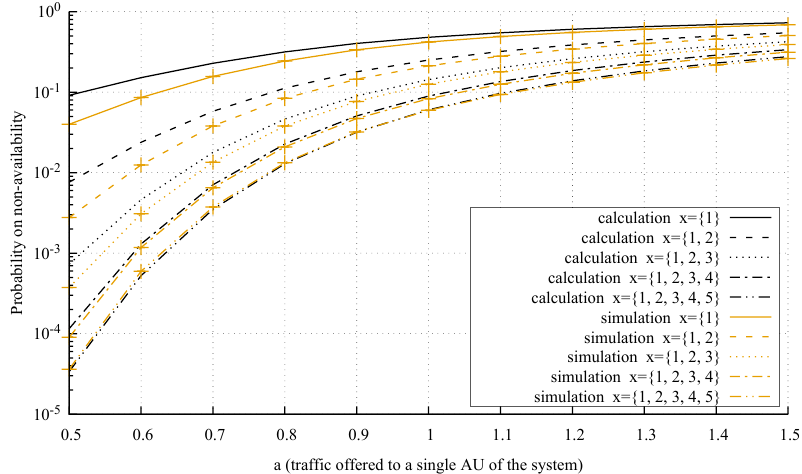
Figure 4. Probability of the non-availability of x strictly determined resources for class 1 calls ( t 1 = 1) in System 2, where x is the set of strictly determined resources in the limited-availability group.